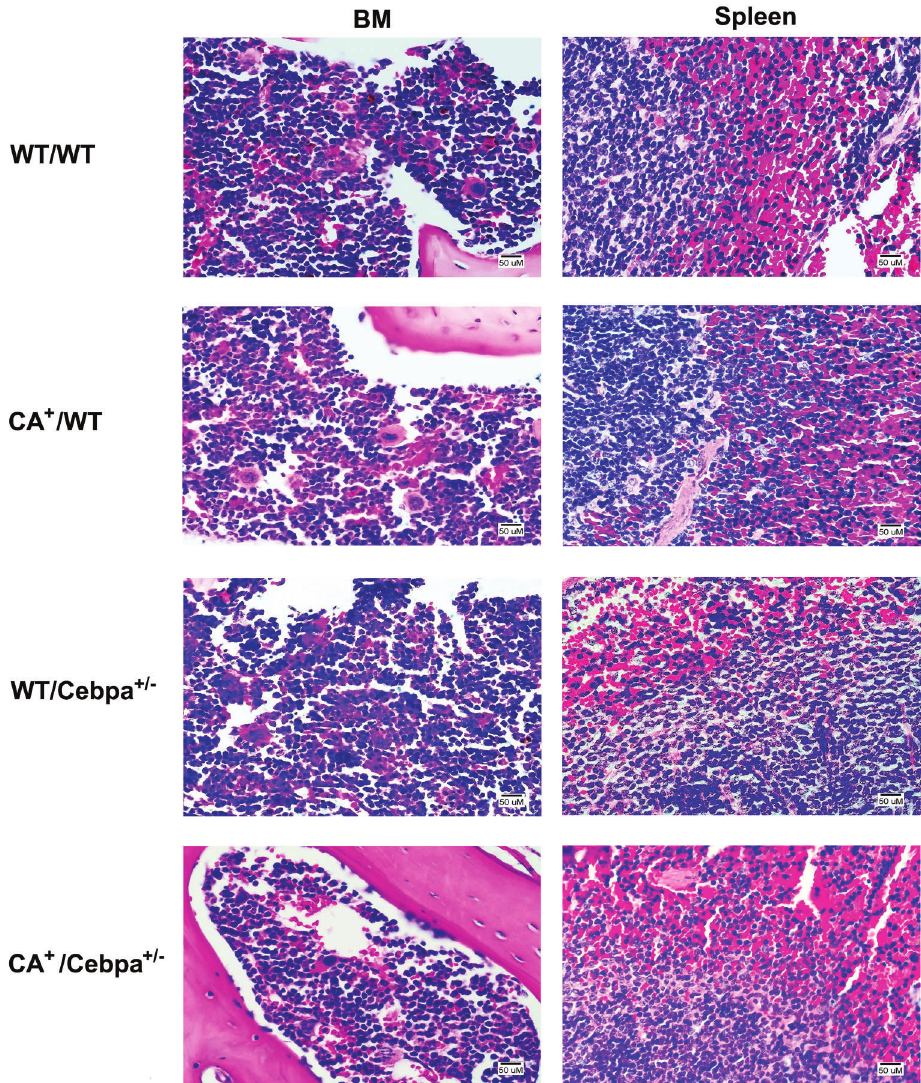
Figure 3. Histopathological analysis of the bone marrow (BM) and spleen from WT/WT : wild-type (control); CA + / WT : CALM/AF10 ; WT/Cebpa + / – : Cebpa + / – ; CA + / Cebpa + / – : double-mutant mice. The normal architecture of the bone marrow and spleen was preserved in CA + / WT , WT/Cebpa + / – , and CA + / Cebpa + / – mice and showed no changes in the cellularity pattern compared to control mice. Hematoxylin and eosin stain. Bar: 50 m